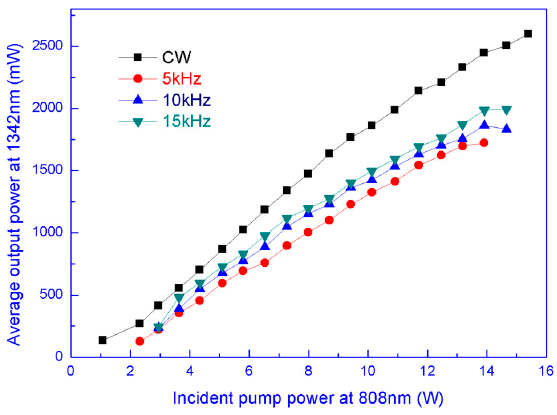
Figure 2. Average output power at 1342 nm with respect to the incident pump power at the PRRs of 5 kHz, 10 kHz, and 15 kHz.